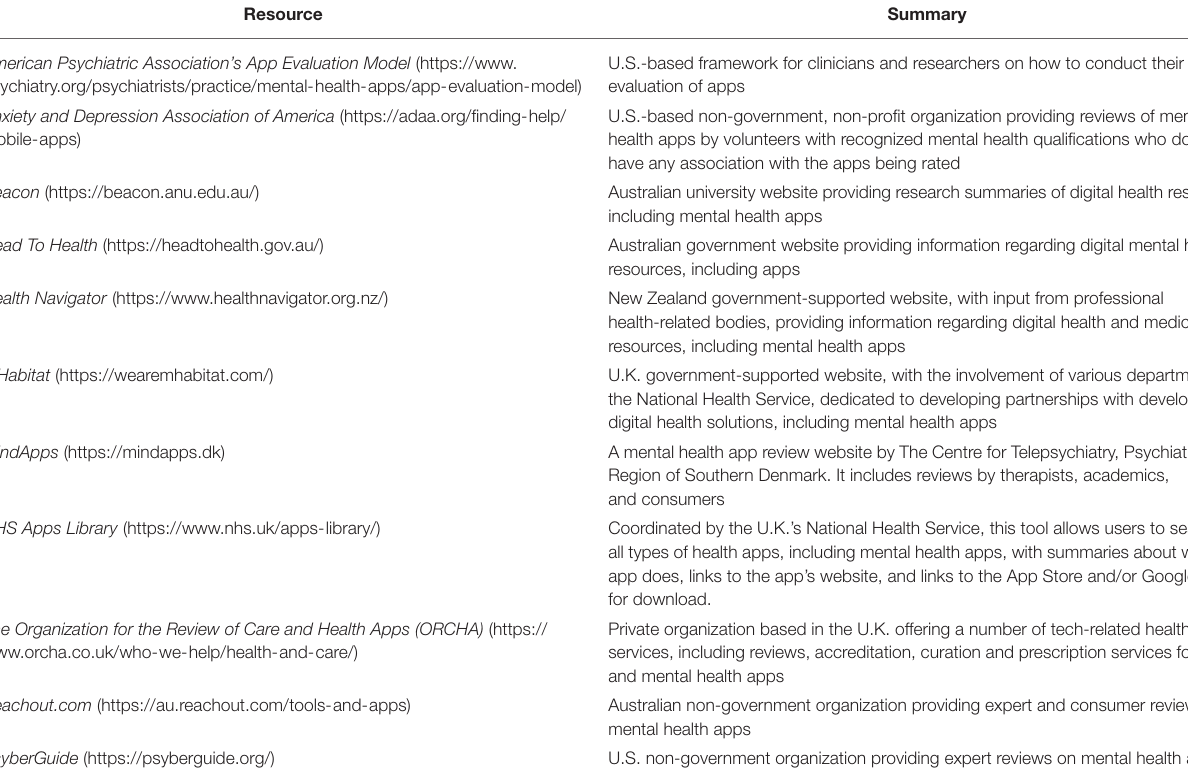
TABLE 1 | Website resources for clinicians that provide reviews and further information on mental health apps for symptoms of trauma.